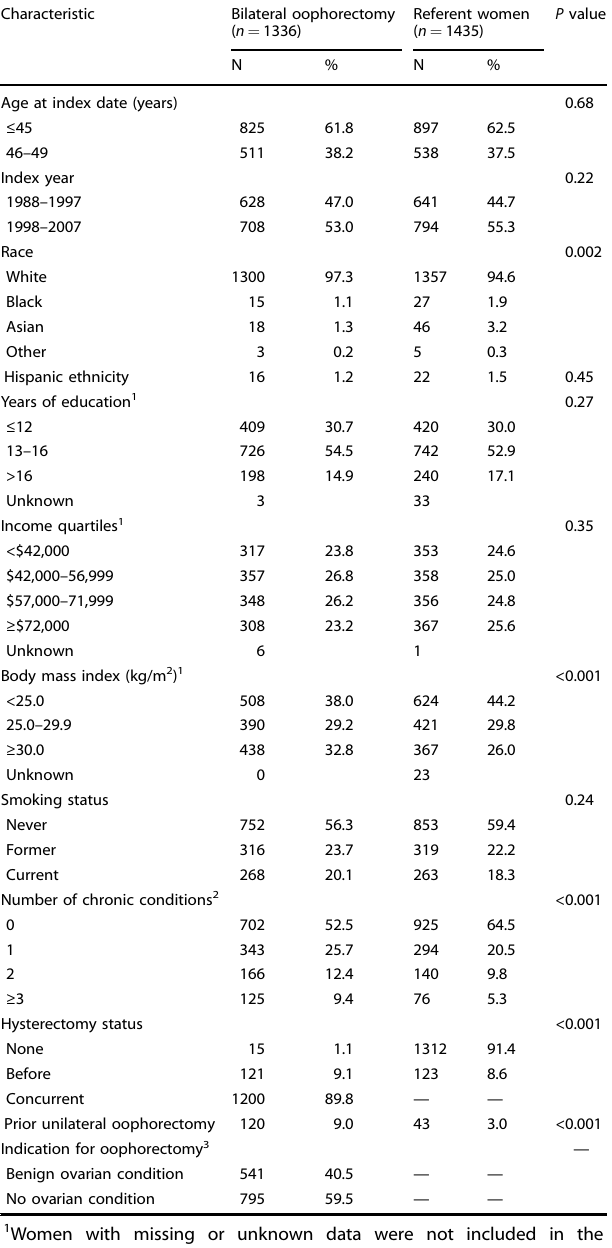
Table 2. Sociodemographic and clinical characteristics at index date of women who underwent bilateral oophorectomy and referent women. Characteristic Bilateral oophorectomy ( n =